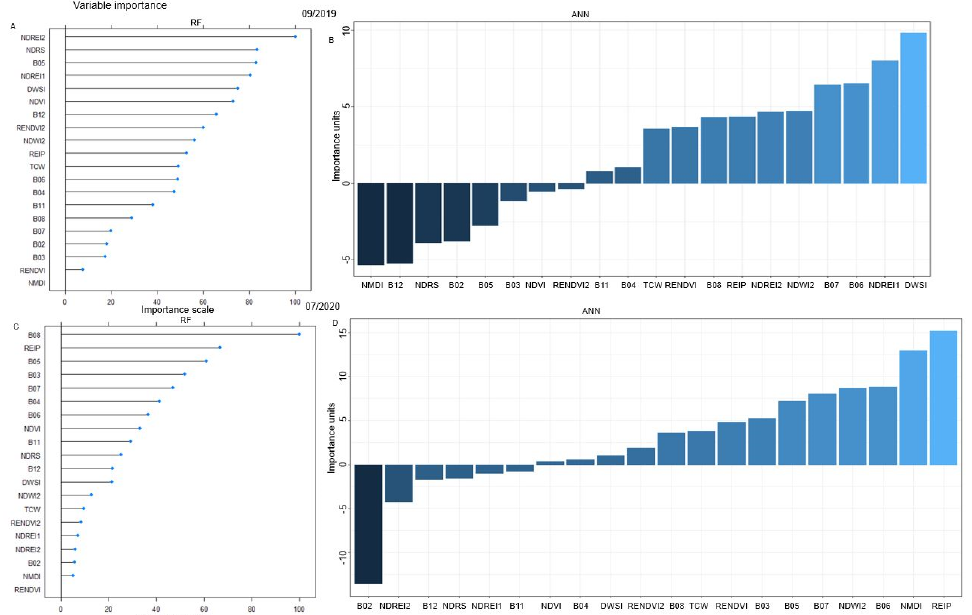
Figure A2. Variable importance for RF and ANN for classification datasets (September 2019 ( A , B ) and July 2020 ( C , D )). Importance values for each explanatory variable for RF are expressed on a scale from 0 to 100 and were calculated with the R “caret” package (version 6.0.91). Variable im- portance for ANN was calculated with the R “NeuralNetTools” package (version 1.5.3) based on relative importance of input variables in neural networks as the sum of the products of raw input– hidden and hidden–output connection weights, proposed by Olden et al. [55]. The importance val- ues assigned to each variable are in units that are based directly on the summed product of the connection weights. The actual values should only be interpreted based on relative sign and mag- nitude between explanatory variables. Comparisons between different models should not be made [55].